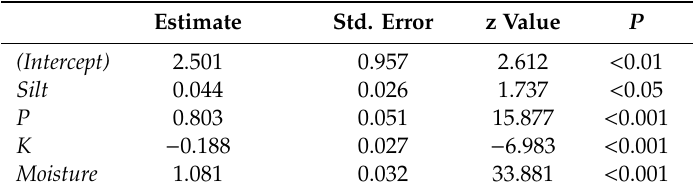
Table 4. Generalized linear mixed model adjusted by maximum likelihood between colony forming units (cfu, n = 132) and the explanatory variables (silt, phosphorus, potassium and moisture). P : Significance